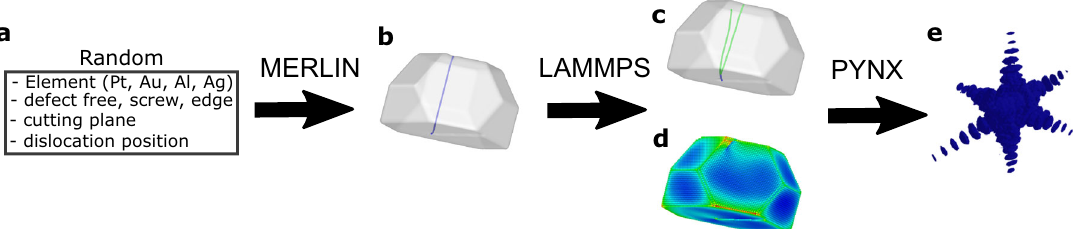
Fig. 1 Schematics of the framework for creating 3D simulated data sets. a A random element, class, crystal surfaces, and dislocation position are selected. b The corresponding crystal is constructed using MERLIN (Rodney (2000 2010). Merlin in a nutshell (unpublished)) and relaxed using LAMMPS 39 . c The dislocation dissociates into Shockley partials and d a strain fi eld builds-up in the crystal. e Finally, the corresponding 3D CXDP is calculated with PyNX 44